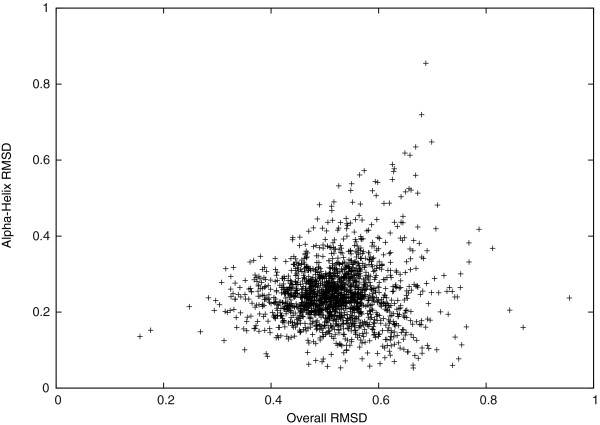
Cα-RMSD of all regions v.s. α-helix regions.